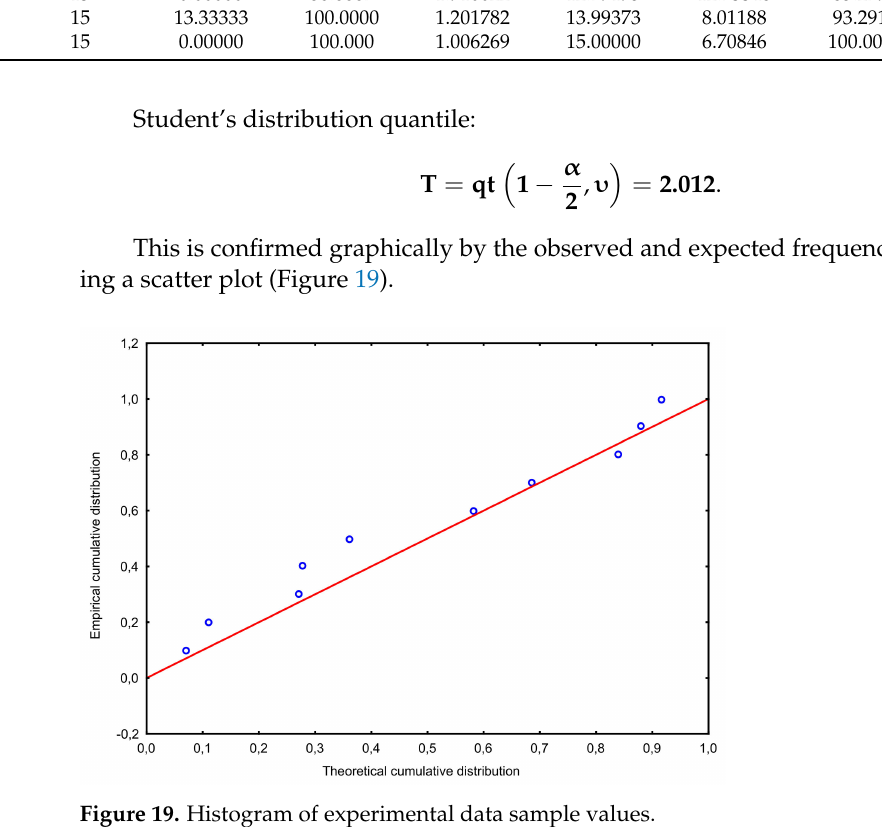
Figure 19. Histogram of experimental data sample